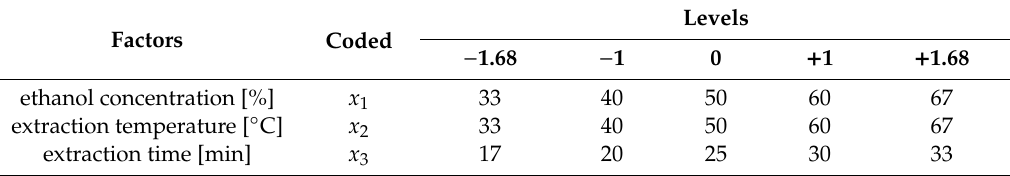
Table 2. Experimental design space for the extraction of phenolic compounds from black locust